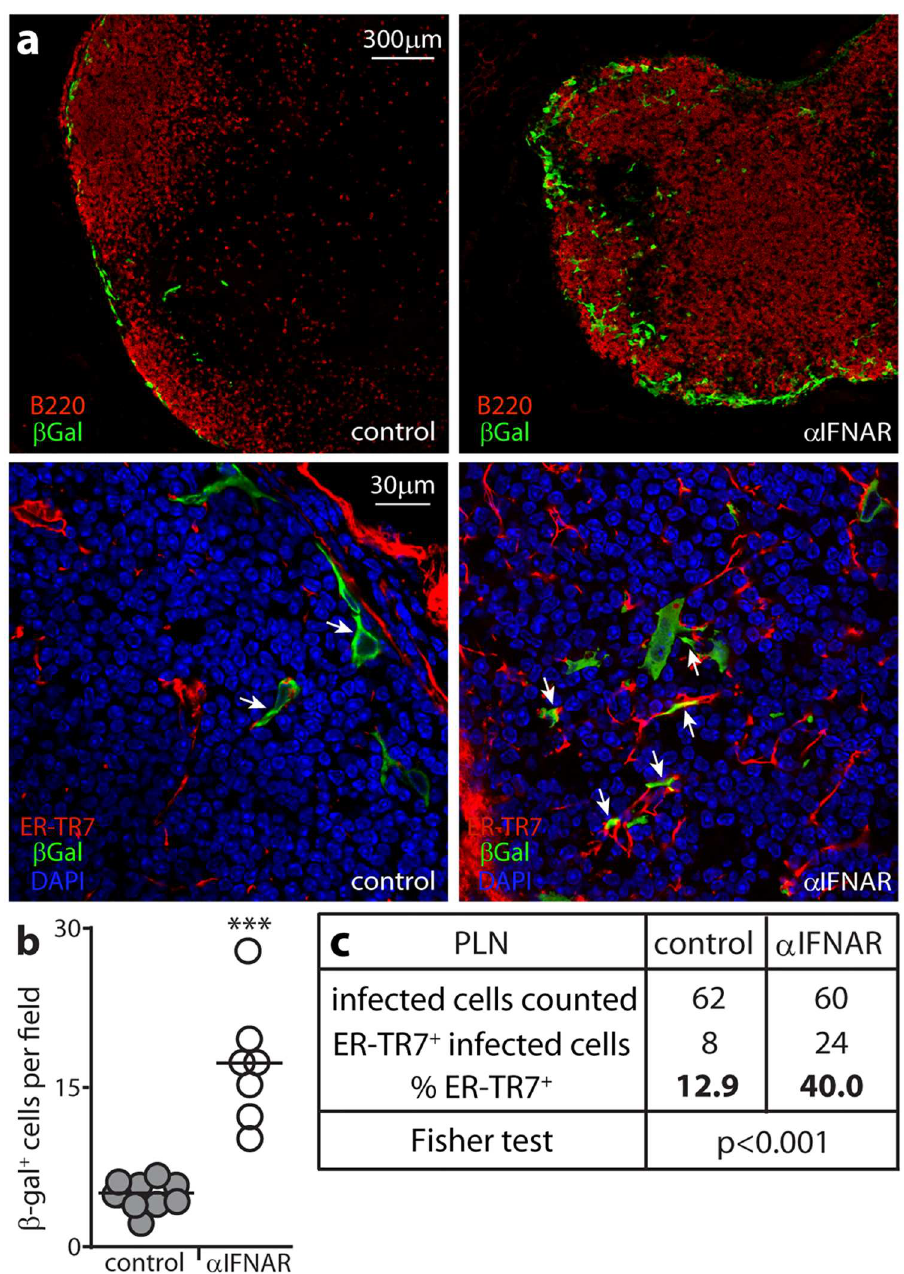
Fig 11. IFN-I protects FRC against direct MCMV infection. (a). C57BL/6 mice were given IFNAR blocking antibody ( α IFNAR) or not (control) then infected i.f. with MCMV in which a β -galactosidase( β gal)expression cassette disrupts the essentialcoding sequenceof gL (10 6 p.f.u.). 1 day later PLN sections were stained for β gal to identify infectionand for B cells (B220, upper panels)or for FRC (ER-TR7) and with DAPI (lower panels). Arrows in the lower panels show exampleinfected FRC. ( b). β gal + cells were counted for 6 fields of view from sections of 3 mice per group. Circles show field counts, bars show means. IFNAR blockade significantly increasedinfection( *** p < 0.001; Student’stwo tailed unpairedt-test with Welch’s Correction). (c). The proportionthat were ER-TR7 + was determined for at least 60 β gal + cells per group (counting more sectionsfrom the controls to reach this total). Fisher’s Exact Test showeda significantly higherproportionof infected cells was ER-TR7 + after IFNAR